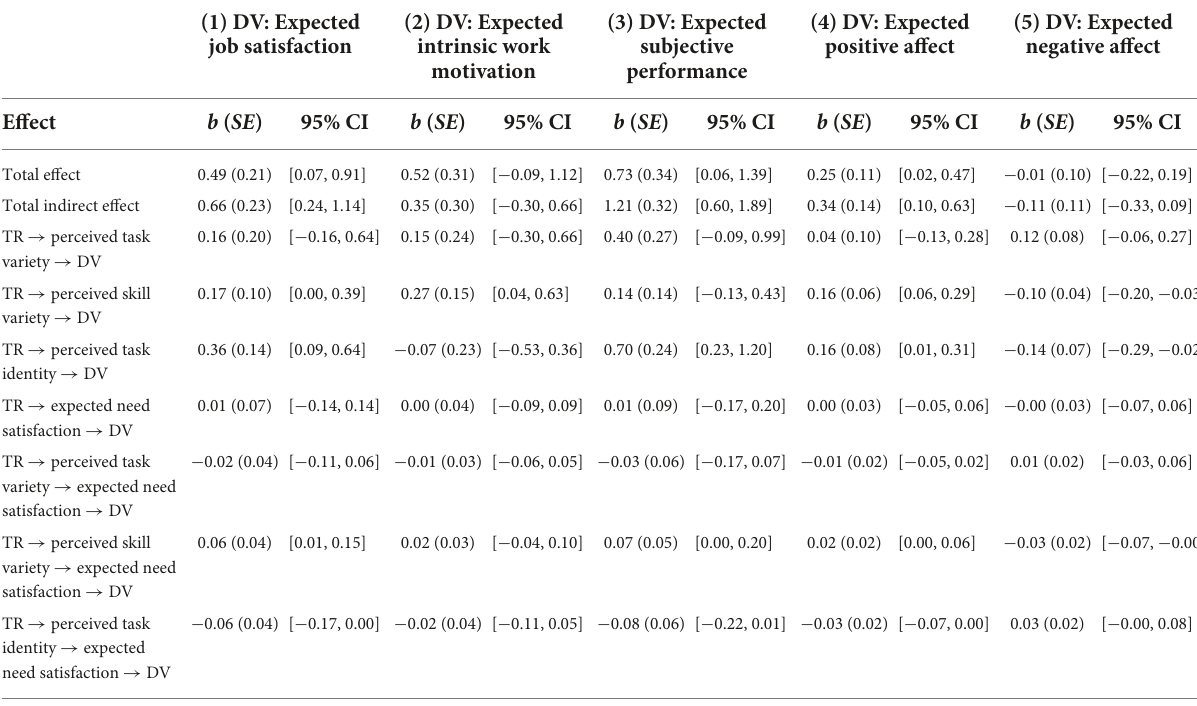
TABLE 8 Total and indirect effects in Study